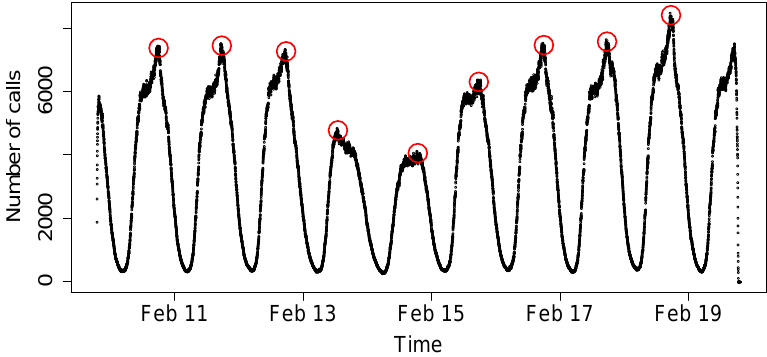
Figure 20. The number of concurrent active calls over nine days. The red circles mark the daily